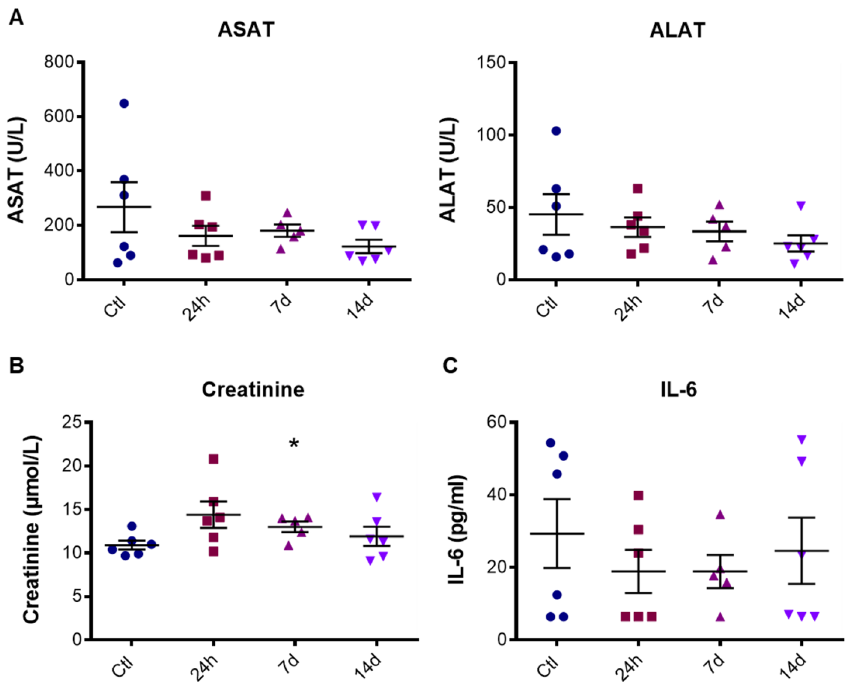
Figure 7. ALAT and ASAT values ( A ), creatinine level ( B ) and IL-6 concentration ( C ) in mouse plasma 24 h, 7 or 14 days after AuNPd injection (1 mg/kg) or 14 days after vehicle injection for the control group. Data represent the mean ± SEM of 6 mice and statistical significance was determined by Student’s t-test ( * p <